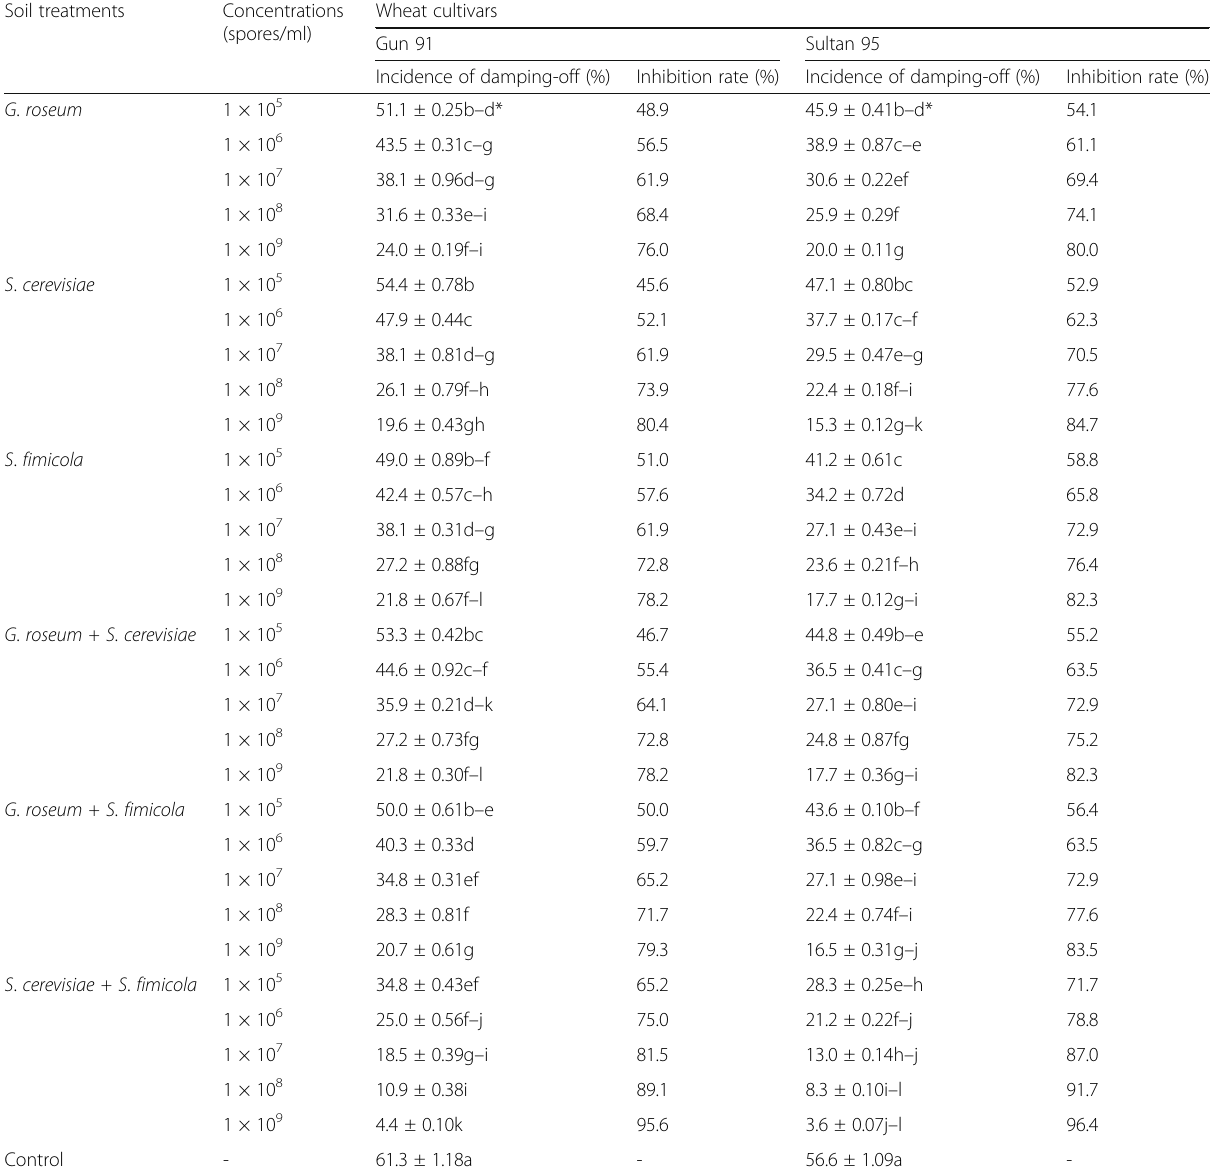
Table 4 Effect of different concentrations of the soil treatments on damping-off caused by F . graminearum in wheat cultivars Soil